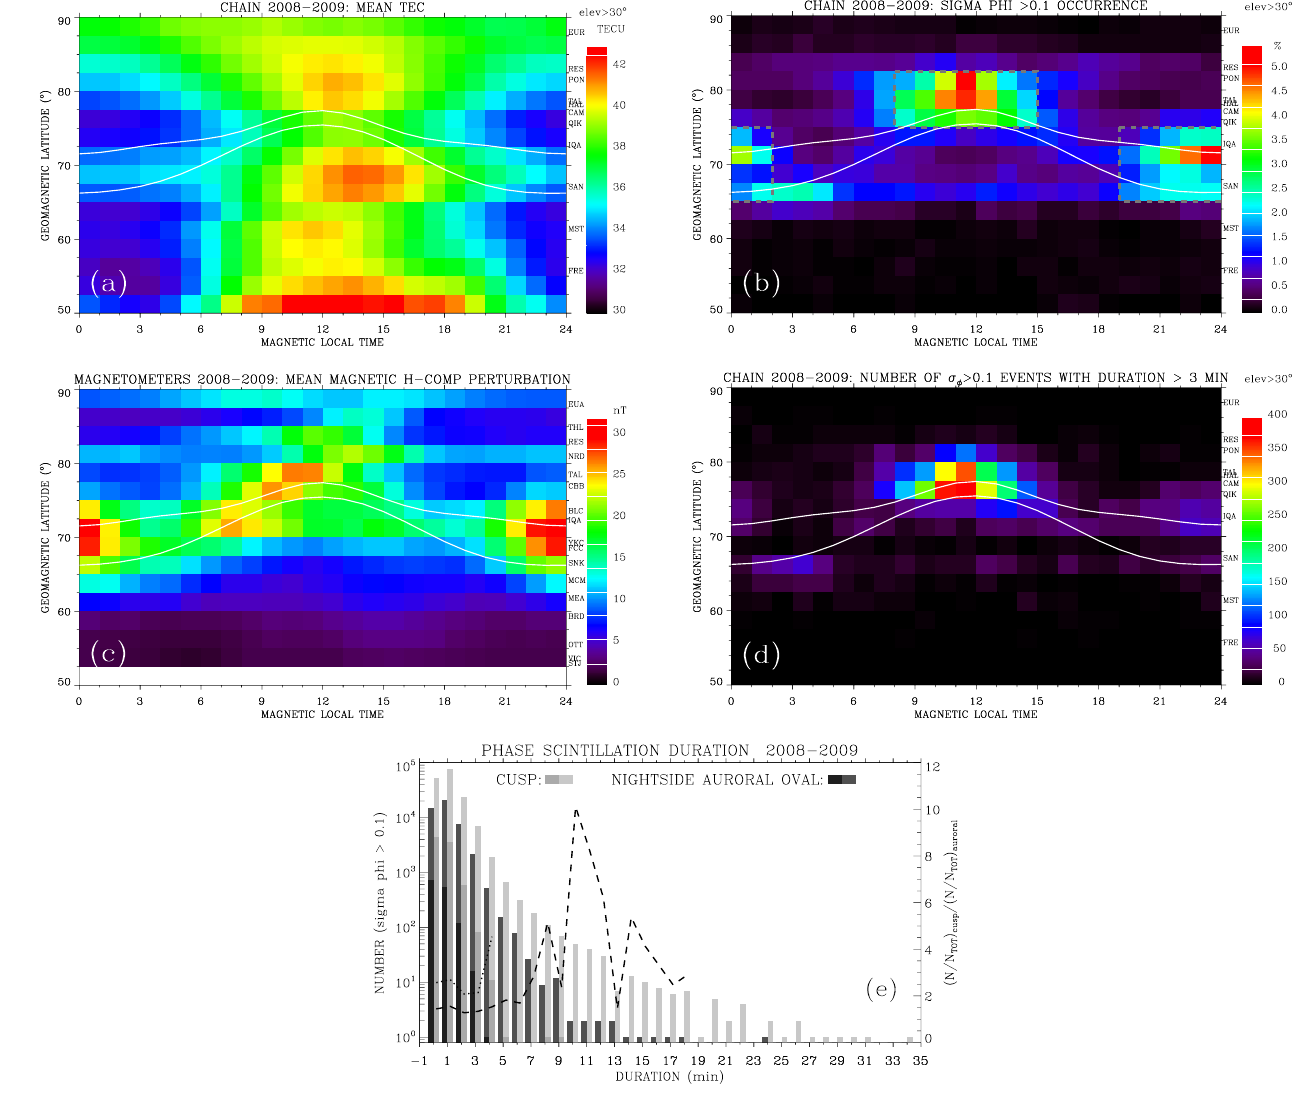
Fig. 5. Maps of (a) mean TEC, (b) phase scintillation occurrence, (c) horizontal component of the mean ground magnetic perturbations due to ionospheric currents, and (d) number of phase scintillation events lasting more than 3min, as a function of MLT and CGM latitude. Su- perposed in white line is the Feldstein oval for IQ=2. Superposed grey dashed rectangular bins in panel (b) indicate the regions representing the cusp and nightside auroral oval used when discussing seasonal variation and anisotropy of irregularities in Figs. 7 and 11, respectively. (e) Number distribution of phase scintillation durations in the cusp and nightside auroral oval. The event numbers shown at 0min represent all one-minute parts after the first minute for events longer than 1min. Darker shading shows events observed concurrently with 2 or more PRNs. Number ratio (on linear scale on the right side) of the cusp and auroral events normalized by the total number of data points is shown in dashed line. The dotted line shows the same ratio for events observed at multiple